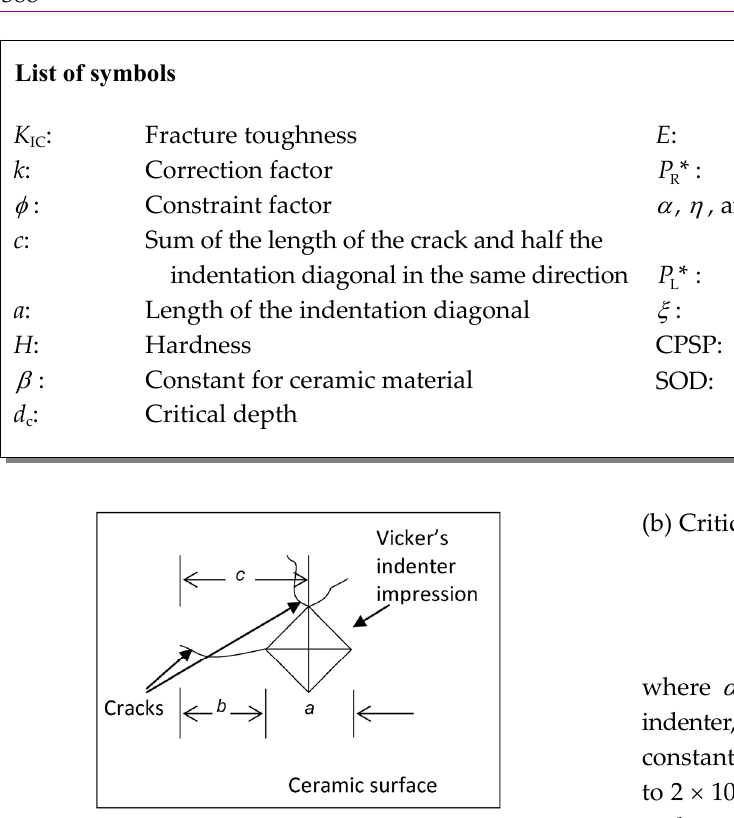
Fig. 1 Schematic of fracture toughness calculation using a Vickers indenter.